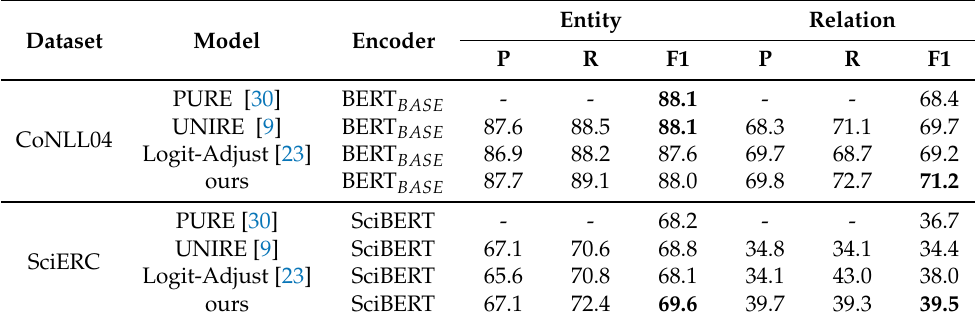
Table 2. Experimental performance of the models on two datasets.